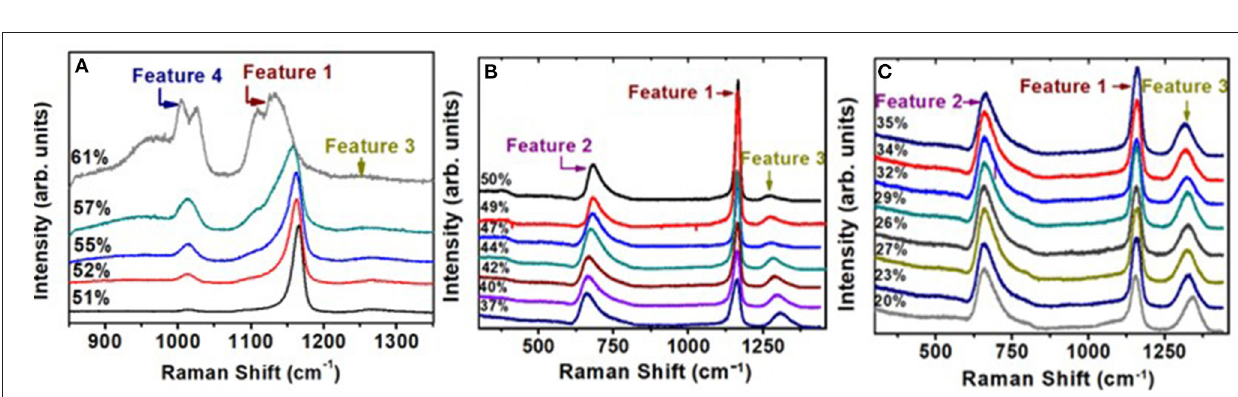
FIGURE 8 | Observed Raman scattering in (Na 2 O) x (P 2 O 5 ) 100 − x glasses as a function of soda content “x.” Spectra (A) are those in the pyrophosphate range, 50% < x < 61% range, while spectra (B,C) are those in the ultraphosphate range, 20% < x 50%. In the 40% < x < 45% range, we do not observe a shoulder near